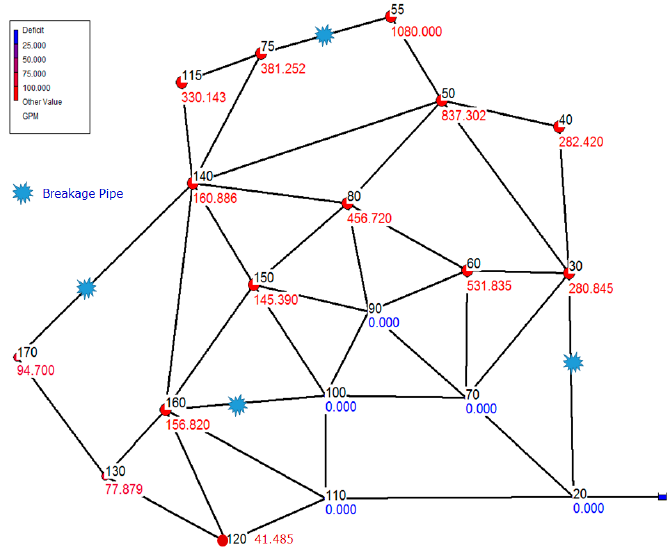
Figure 6. Results of estimation of the usage that can be supplied by node according to scenario S1.